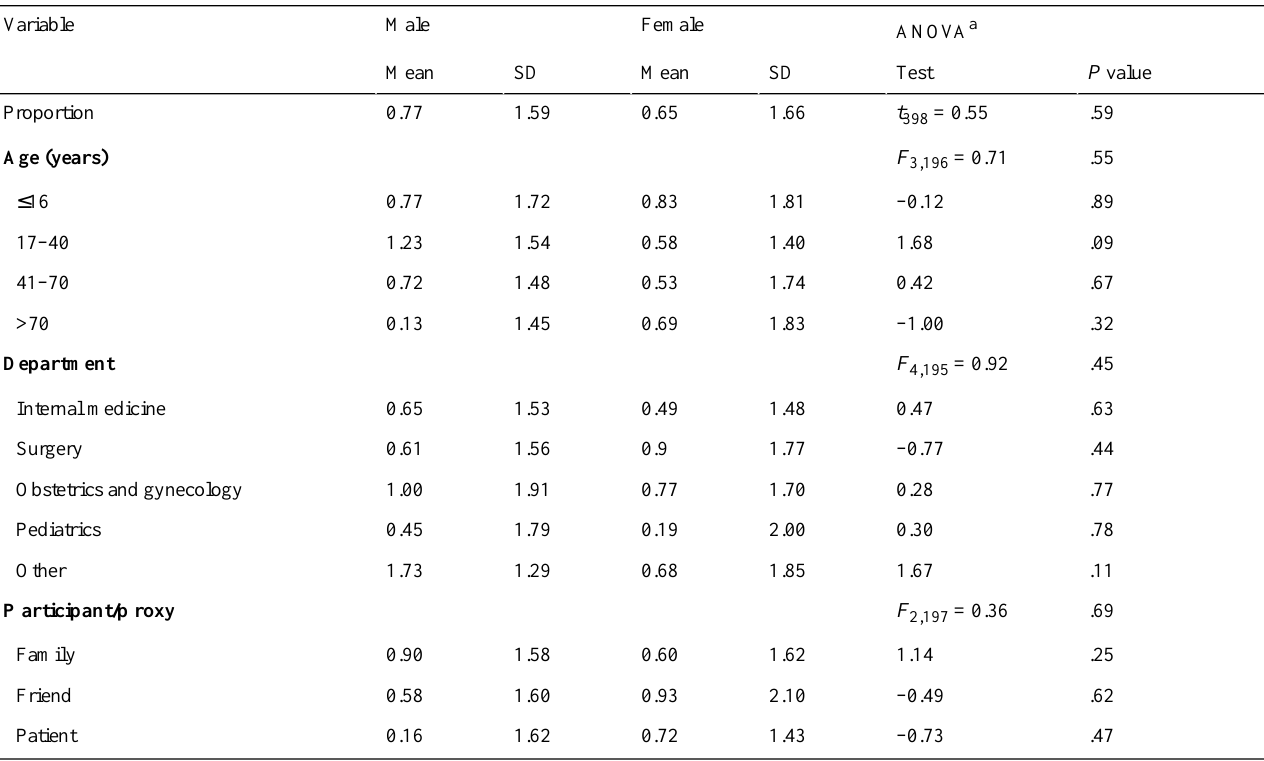
Table 4. Comparison of inpatient perception by demographic characteristic